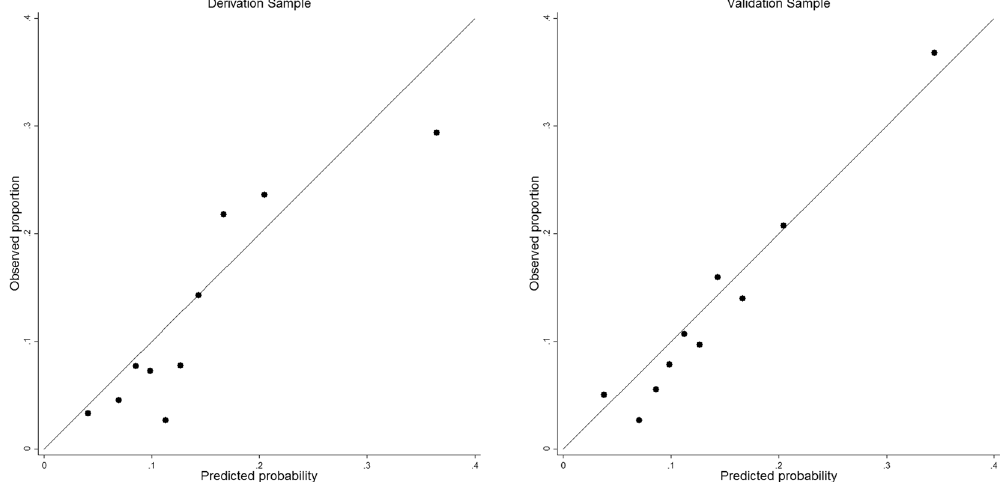
Figure 1. Assessing calibration in the derivation cohort (left) and the derivation cohort (right).